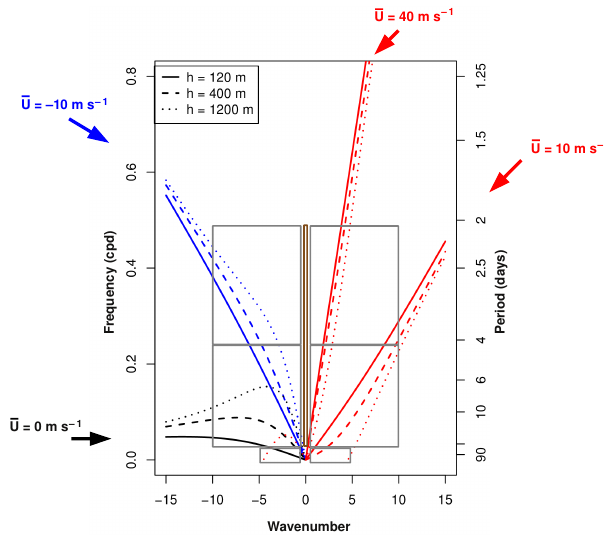
Figure 1. Dispersion curves for forced planetary waves at 50 ◦ N un- der different mean zonal wind regimes (line colors and winds speci- fied outside the diagram), and differentiating equivalent depths (line type, top-left box). Filter bounds in the wavenumber–frequency do- main are shown as grey boxes (brown for wavenumber